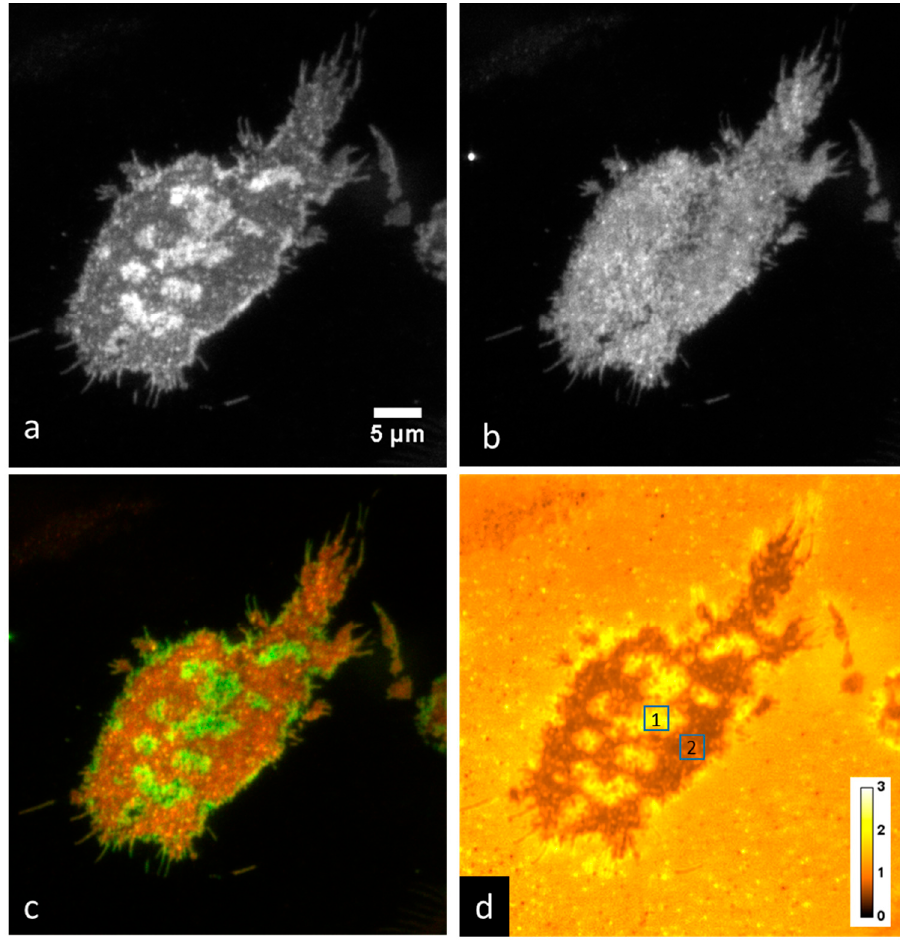
Figure 2. Imaging membrane curvature with DiI-C 16 in RBL-2H3 cells grown on a coverslip acquired with an Evolve 512 EMCCD camera. Shown are ( a ) P-polarized excitation, ( b ) S-polarized excitation, ( c ) red-green two-color overlay of P-polarized excitation and S-polarized excitation, ( d ) average of ten P-polarized excitation and S-polarized excitation ratio (P / S) images. Region of interest (ROI) 1: P / S = 1.822 ± 0.295; ROI 2: P / S = 0.694 ± 0.0661.